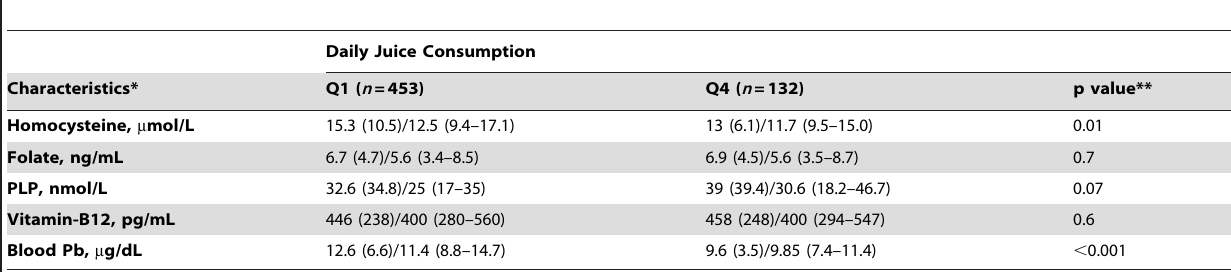
Table 3. Concentrations of plasma/serum homocysteine, folate, PLP, vitamin B12 and blood Pb in quartile 1 versus quartile 4 of daily juice consumption.